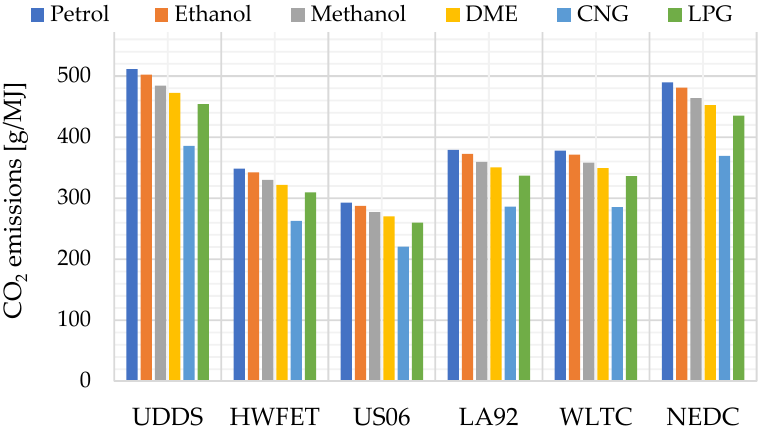
Figure 16. Summary of the final CO 2 emissions per MJ obtained from simulations of the 2018 Toyota Camry LE vehicle for selected road tests.